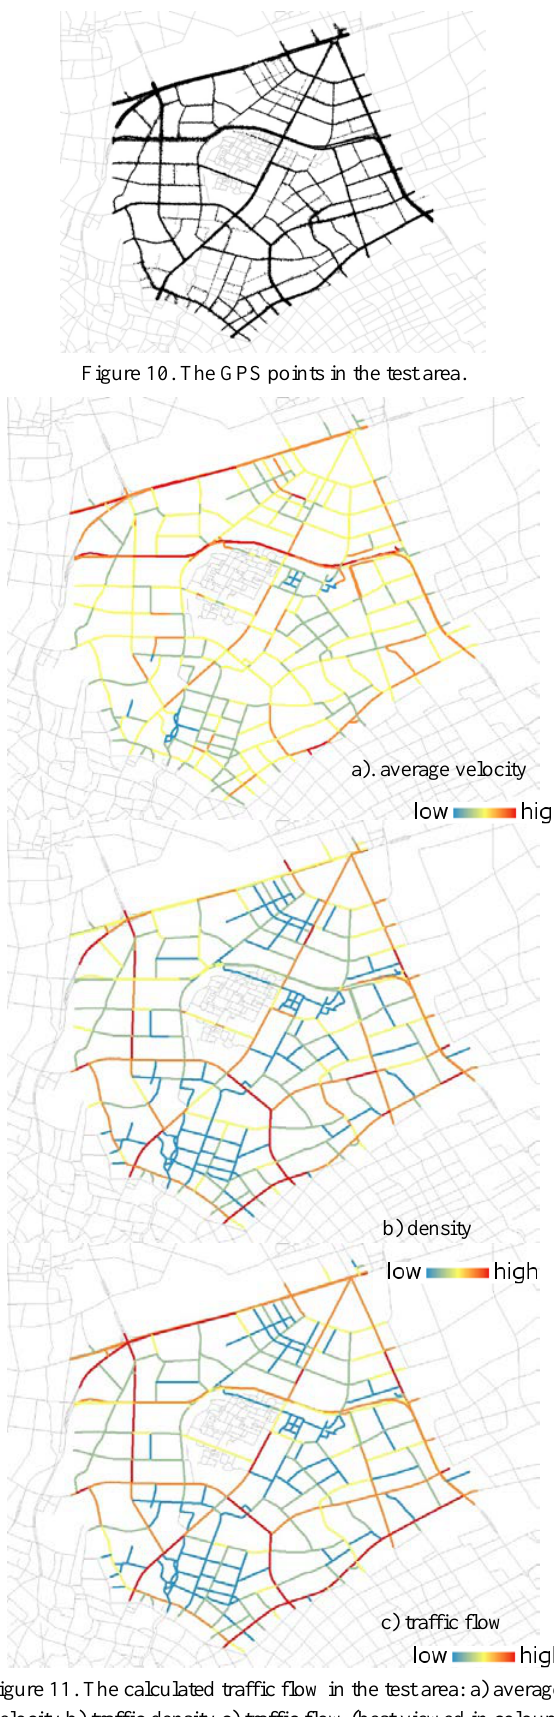
Figure 11. The calculated traffic flow in the test area: a) average velocity b) traffic density c) traffic flow (best viewed in colour)